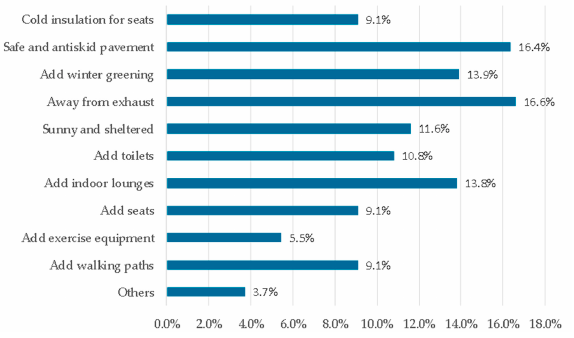
Figure 5. Demand factors for the green spaces.